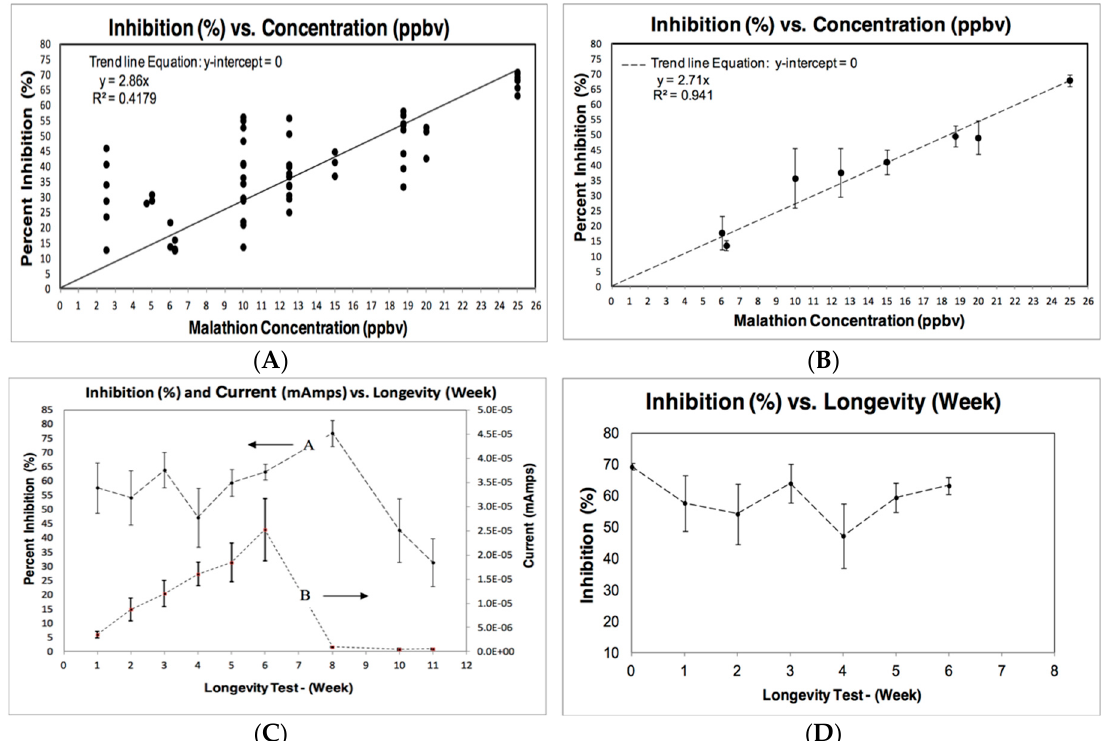
Figure 4. Biosensor test data results: ( A ) Malathion concentration from 0 ppbv to 25 ppbv, ( B ) Malathion concentration from 6 ppbv to 25 ppbv. BChE/BSCh Longevity Test: ( C ) Inhibition measured after biosensor exposure to 25 ppbv malathion, ( D ) First six weeks after biosensor exposure to 25 ppbv malathion.